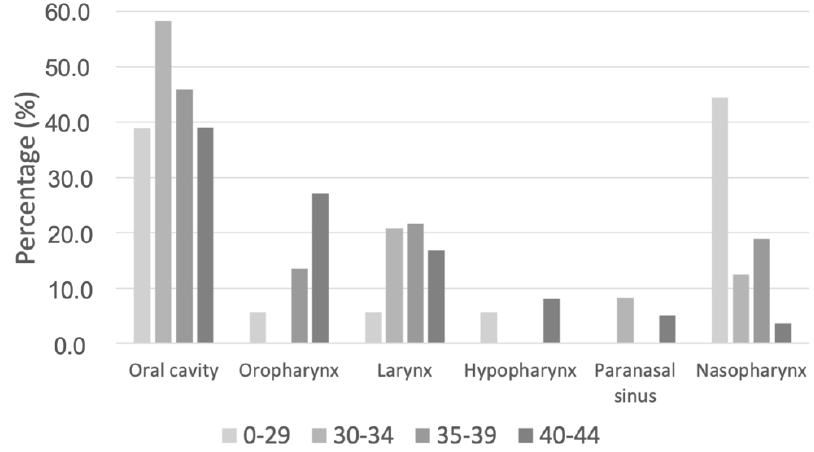
Figure 3. Distribution of tumor subsites in age-categorized patients under 45